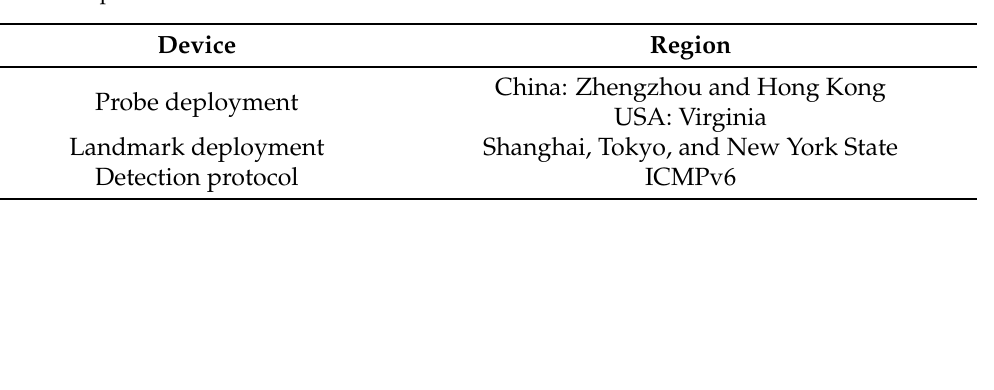
Table 1. Experimental